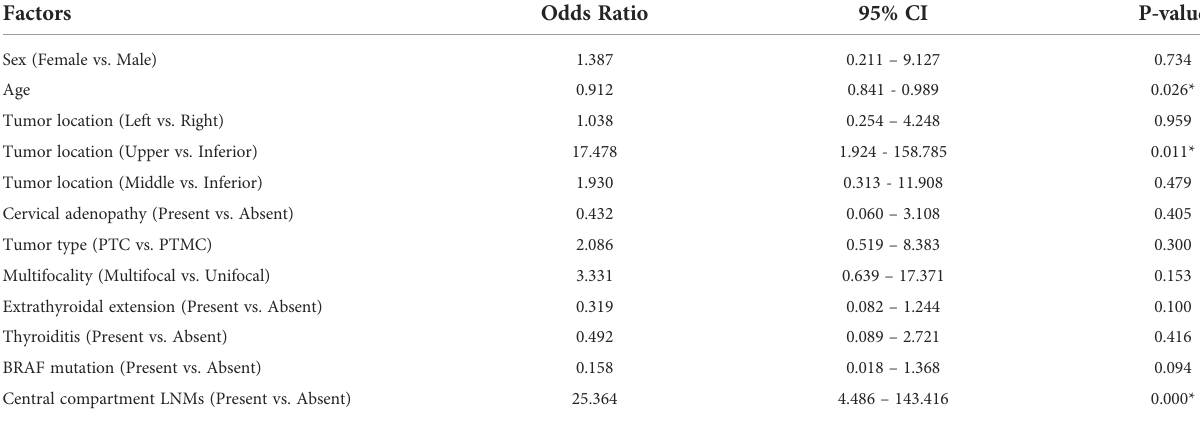
TABLE 4 Multivariate analysis of the clinicopathological factors for patients with lateral compartment LNM (n = 78). Factors Odds Ratio 95%